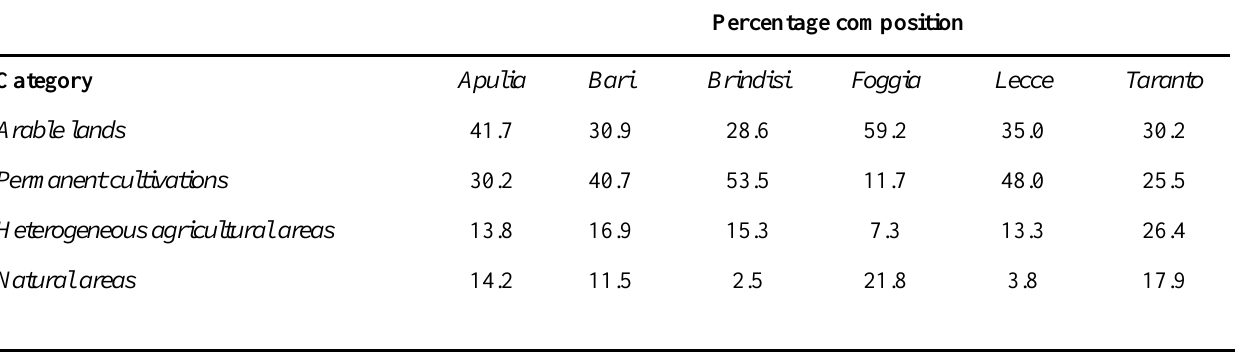
Table 1. Broad land-use/land-cover categories of Apulia and its five nested administrative provinces, based on the aggregation of Corine classes from 1999 land-use/land-cover map (see text). Percentages sum up to 100% and are calculated only for terrestrial surface by excluding seawater, lagoons, wetlands and urban fabrics (adapted from Zurlini et al.